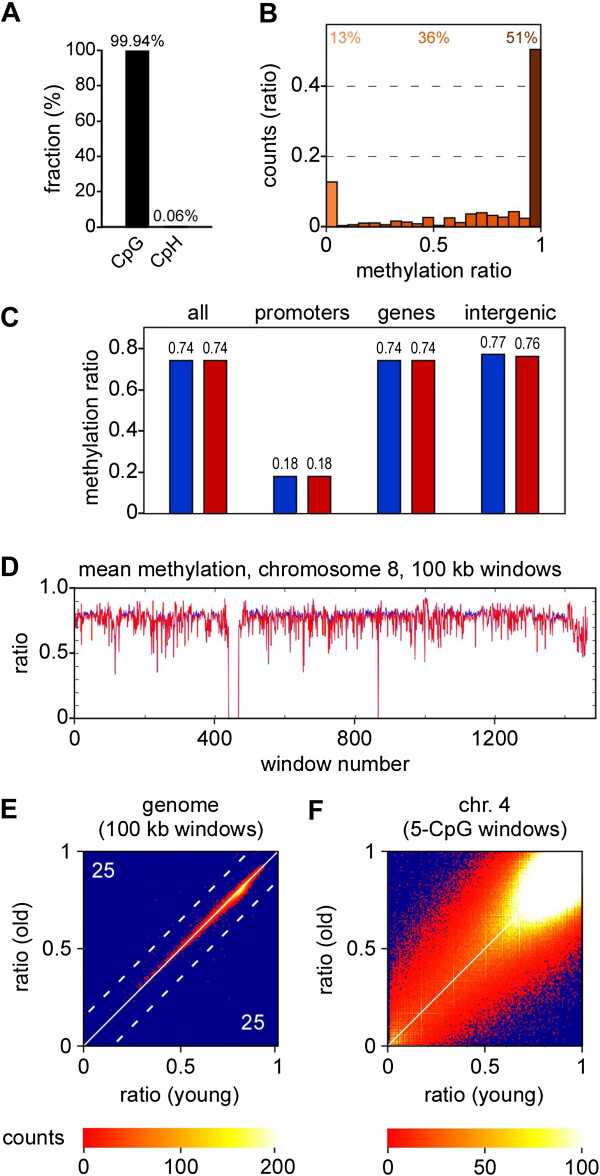
The methylome of the aging human epidermis. (A) Dinucleotide context of non-converted cytosine residues. (B) Methylation levels of individual CpG dinucleotides. Average methylation levels were determined for all covered CpG dinucleotides and then distributed into bins with increasing methylation ratios. Percentages indicate the fractions of unmethylated (light orange), partially methylated (orange) and completely methylated (dark orange) CpGs. (C) Average DNA methylation ratios of the genome (all), promoters, gene bodies and intergenic regions are shown for the young (blue) and old sample (red), respectively. (D) The methylation pattern of chromosome 8, shown in tracks of 100-kb windows. The blue line indicates the young sample, the red line indicates the old sample. (E) Density plot of average methylation ratios for 100-kb windows covering the entire genome. Numbers indicate the number of windows with a methylation difference >0.15 (dotted line). (F) Density plot of average DNA ratios for 5-CpG windows covering chromosome 4.